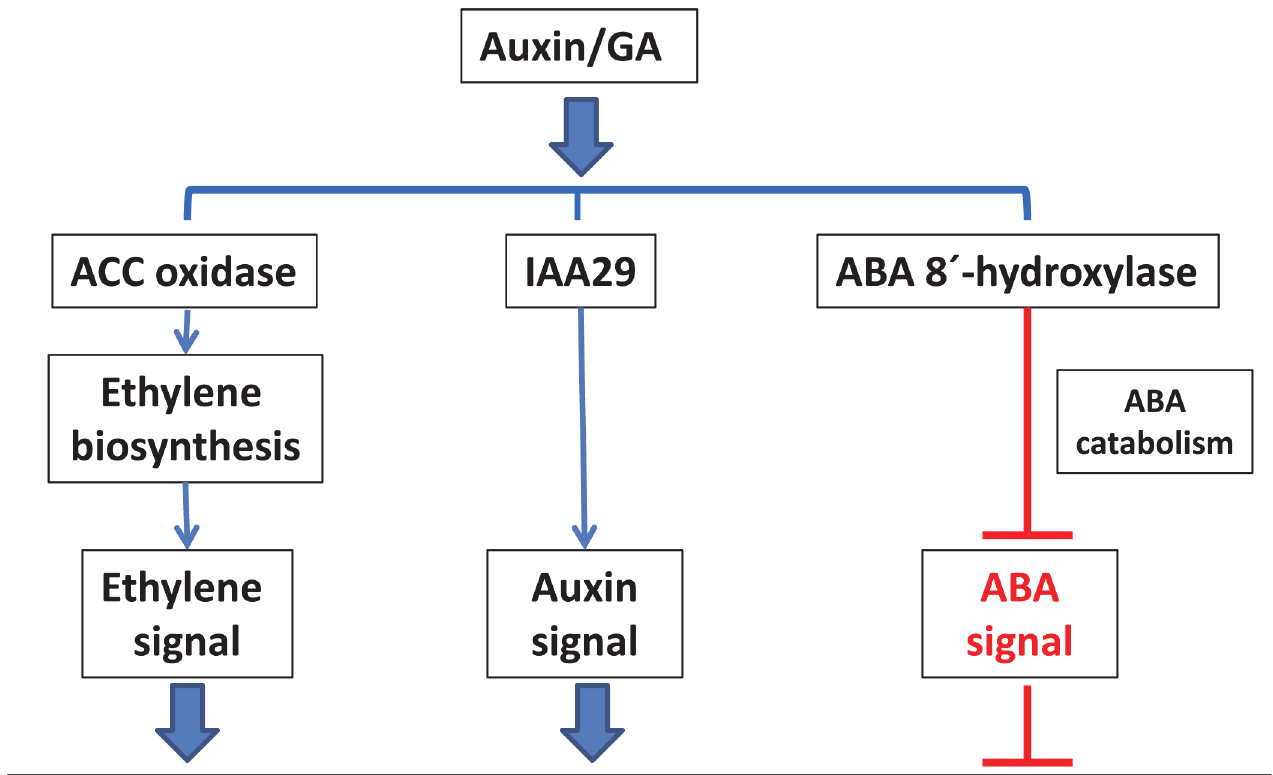
Fig 9. Genes co-regulated in vitro and in planta with MYB25-like